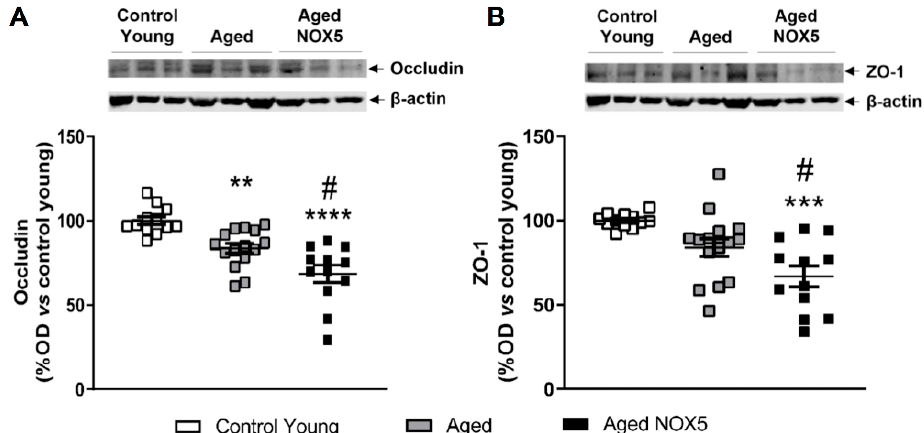
Figure 7. Cerebral occludin and ZO-1 protein expression. Occludin, ZO-1 and β -actin representative immunoblots from mice brain tissue and their quantification. ( A ) Cerebral occludin protein levels expressed as a percentage of the optical density (% OD) in the aging mice vs . the Control Young group. ** p < 0.01, **** p < 0.0001 vs . Control Young and # p < 0.05 vs . Aged . ( B ) Cerebral ZO-1 protein levels expressed as a percentage of the optical density (% OD) in the aging mice vs . the Control Young group. *** p < 0.001 vs . Control Young and # p < 0.05 vs . Aged . n = 13–19. The results are expressed as the mean ± SEM. Control Young : young mice, Aged : CRE +/ − aging mice and Aged NOX5 : NOX5 +/ − CRE +/ − aging mice.